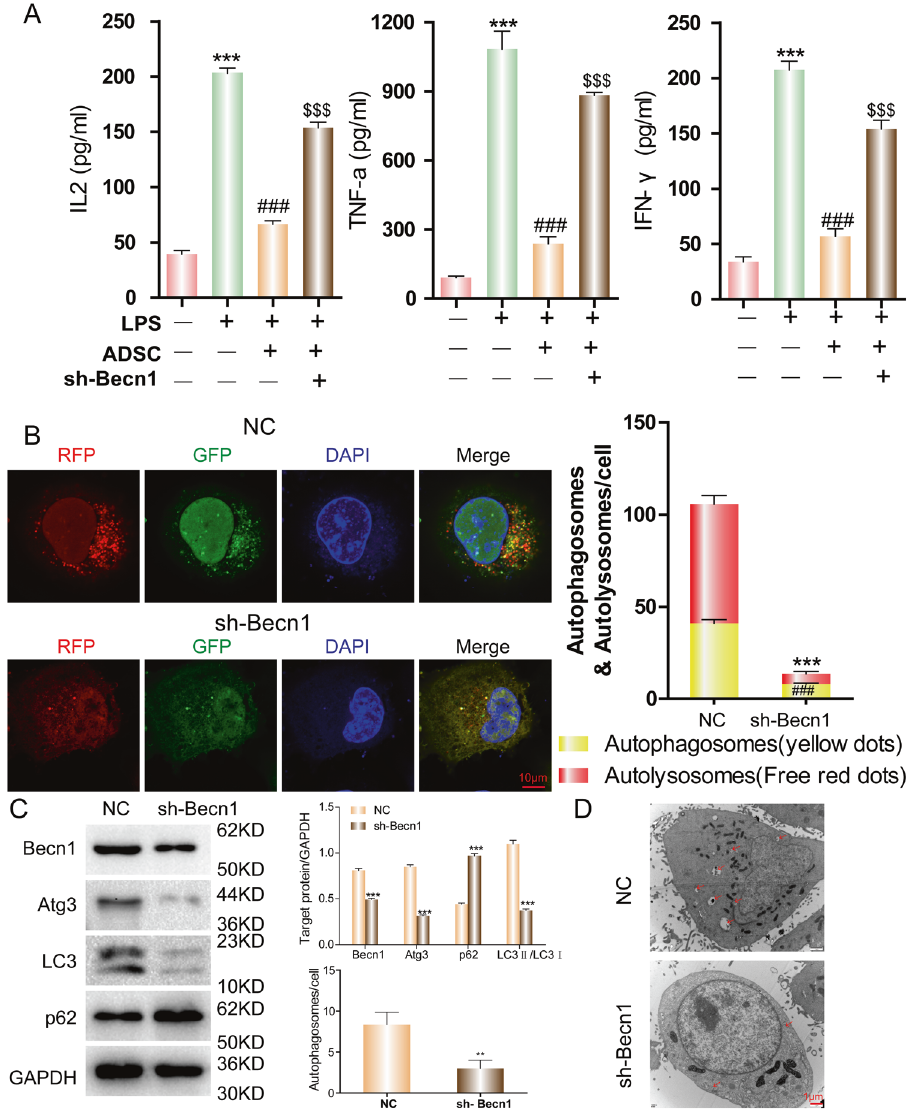
Fig. 4 The role of autophagy on the anti-in fl ammatory function of ADSCs. ADSCs were cultured in vitro, and becn-1 expression in ADSCs was knocked down by shRNA. Alveolar epithelial cells (MLE-12) were cocultured with ADSCs using a Transwell system. The MLE-12 cells were subsequently stimulated with LPS. A In fl ammatory cytokines IL-2, TNF- α , and IFN- γ in the supernatants of different groups were detected by ELISA. *** P < 0.001 vs control group; ### P < 0.001 vs LPS group; $$$ P < 0.001 vs LPS + ADSC group. B Autophagy in cocultured ADSCs was detected in accordance with the mRFP-GFP-LC3 dual- fl uorescence autophagy indicator system under a confocal microscope. *** P < 0.001; ### P < 0.001. C The levels of autophagy-related protein indicators in cocultured ADSCs were detected by WB. *** P < 0.001. D The level of autophagosomes in cocultured ADSCs was detected by electron microscopy. Red arrows indicate the autophagosomes. The experiment was repeated triple. Data are shown as means ± SD, ** P < 0.01 (determined by unpaired t test or one-way ANOVA with Tukey comparisons). human ALI include lung infection, aspiration, sepsis, multiple trauma, role of ADSCs is dependent on mTOR signaling maintained by and shock [1]. Mouse models of experimental lung injury based on autophagy. Considering that ALI pathogenesis is primarily caused by different types of risk factors have been used to investigate the injury to both the vascular endothelium and alveolar epithelium [1], underlying mechanisms [33]. LPS is recognized as the most our study yields important evidential support to the development of important mediator of gram-negative bacteria-induced sepsis, and ADSC transplantation for the treatment of human ALI; however, our the systemic administration of LPS in mice is considered to be the evidence does not extend beyond the effect-mechanism association classic approach for modeling the consequences of bacterial sepsis. involving autophagy. In particular, when considering that pathological This is precisely why an LPS-induced ALI model was selected for the changes in human ALI (e.g., neutrophilic alveolitis, injury to the study of the therapeutic effect of ADSCs. However, for otherwise alveolar epithelium and endothelium, hyaline membrane formation, induced ALI, our animal model may not be as appropriate in terms and microvascular thrombi), potential minor in fl uences of other cells of pathogenicity. In an LPS-induced ALI model, the capillary in the lung tissue should be considered before the clinical therapeutic endothelium represents the initial site of tissue injury following ef fi cacy can truly be justi fi ed. intravenous LPS administration. Moreover, LPS-induced tissue injury It is important to note that this is the relevance of our animal appeared to be related to apoptosis [34]. Cell death and tissue model to human cases. Previously established major causes of